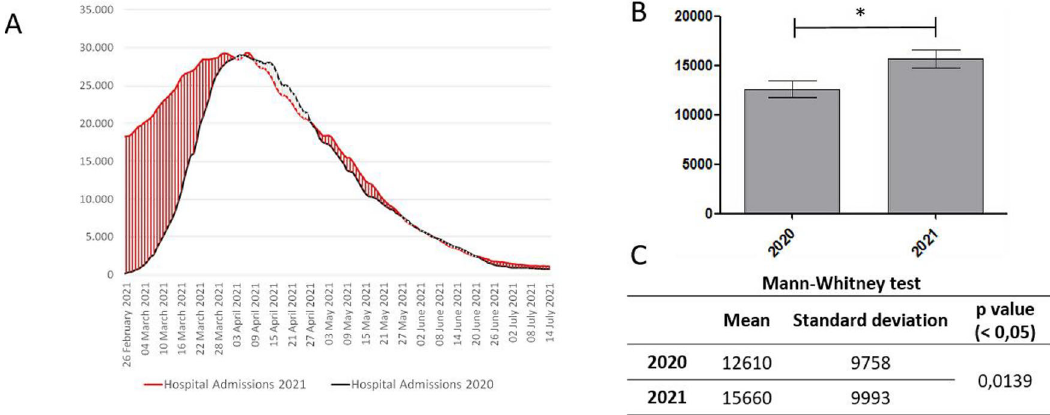
Figure2.A.TrendoftheHospitalizedwithsymptomsvariable;B.Significantdifferencesbetweentwoperiods, with *p < .05; C. Mean, Standard deviation, p value.